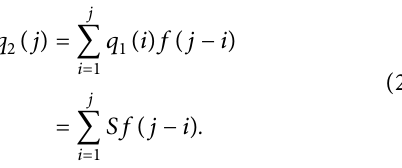
Figure 1: Traffic flow platoon